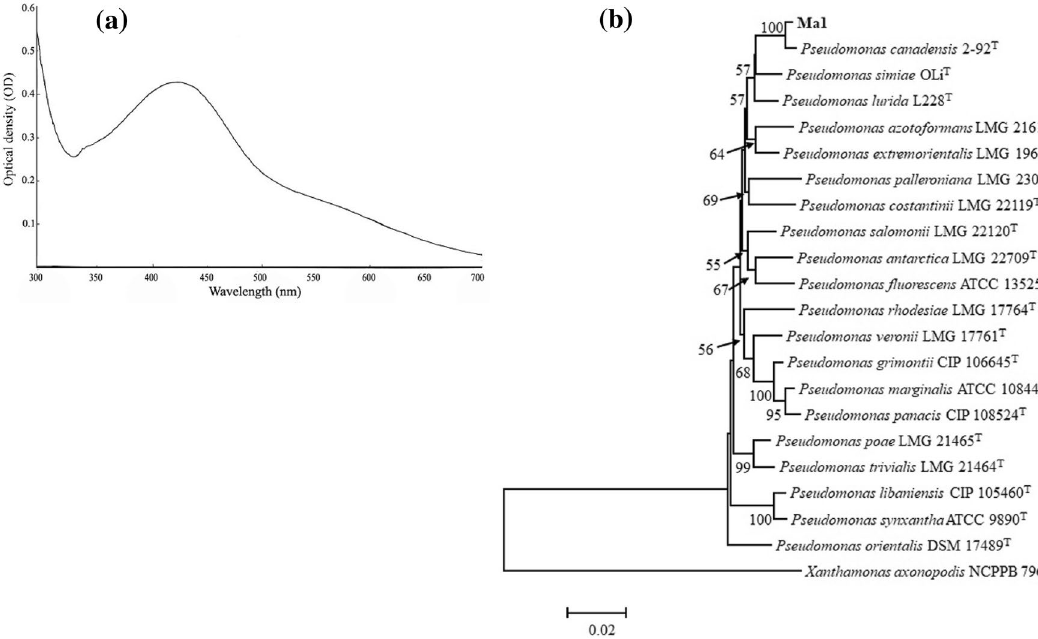
Figure 1. ( a ) The UV–Visible absorption spectrum of the AgNPs solution synthesized with Pseudomonas canadensis Ma1. AgNPs display a clear absorbance peak at 400–450 nm, and ( b ) Phylogenetic tree of partial 16S rRNA and rpoD gene sequences showing the position of Ma1 strain (shown in bold) in addition to taxonomically similar selected reference strains. The analysis was conducted by the Maximum Likelihood method with Tamura-Nei calculation model in MEGA version 6.0. The scale bar represents the number of substitutions per site. Numbers at branching points indicate bootstrap value derived from 1000 replicates.